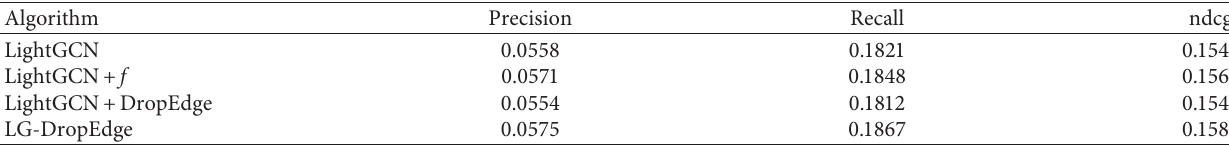
Table 4: Performance of the Gowalla dataset under the four algorithms.